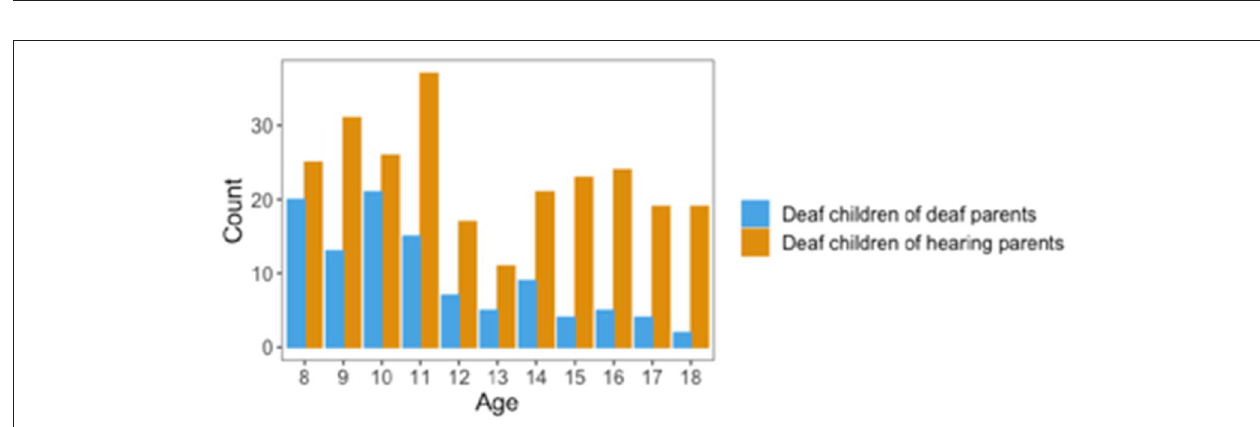
FIGURE 2 | Number of participants with deaf parents ( n = 105) and hearing parents ( n = 251) at each age.